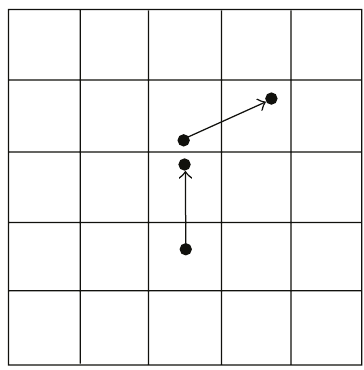
Figure 3: The node in the center cell may experience very large in- terference in this